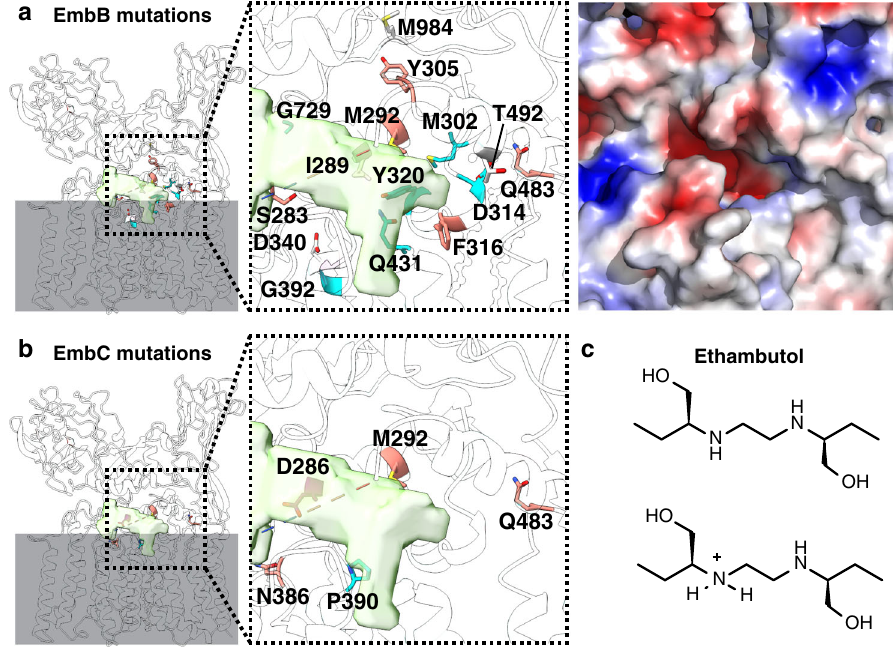
Fig. 3 Ethambutol resistance mutations of EmbB and EmbC. Mutations known to confer resistance to ethambutol in EmbB ( a ) and EmbC ( b ) are mapped on the overall structure and as a zoom-in, with their side chains displayed and colored based on the ConSurf score as in Fig. 2. The other regions of the EmbB model are rendered semi-transparent. The electrostatic potential of the zoom-in region of EmbB is shown on the right. c Chemical structure of ( S , S )- ethambutol, showing both its neutral and one of two single positively charged